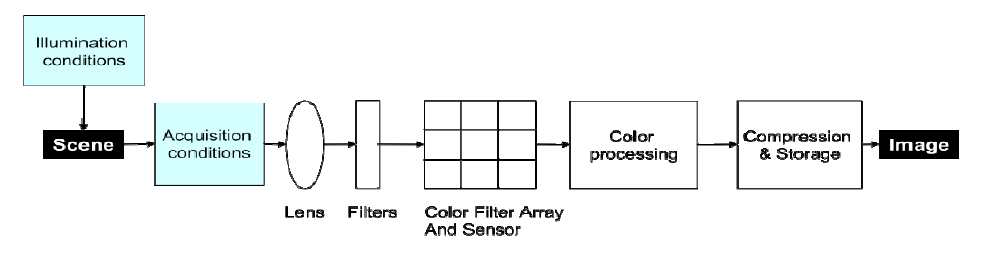
Figure 1. Environment-dependent (blue boxes) and camera-related (white boxes) factors involved in the image acquisition